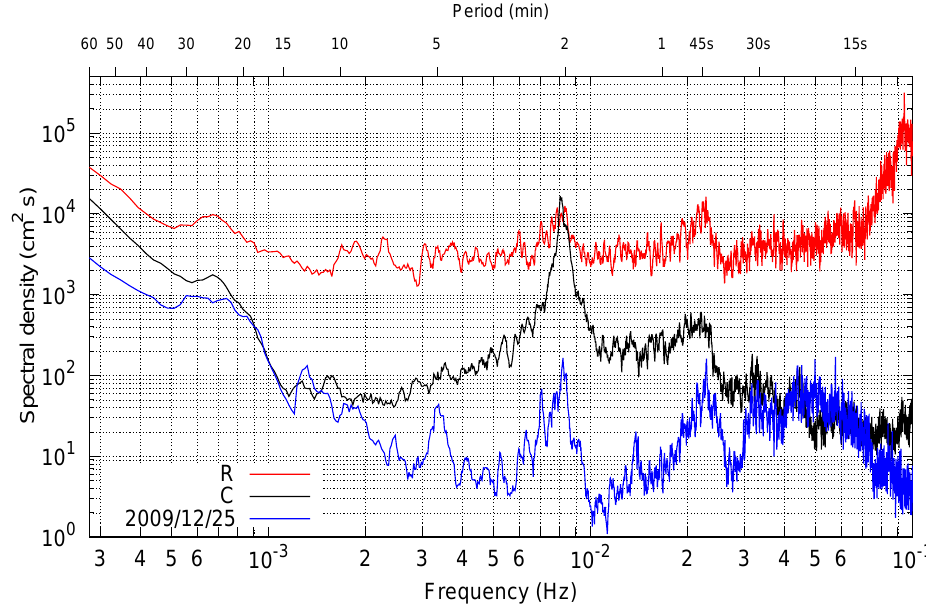
Fig. 5. Power spectral density (PSD) of Tremestieri in the case of rough sea conditions ( R ), calm sea ( C ) and in absence of ferry signals (25 December 2009).